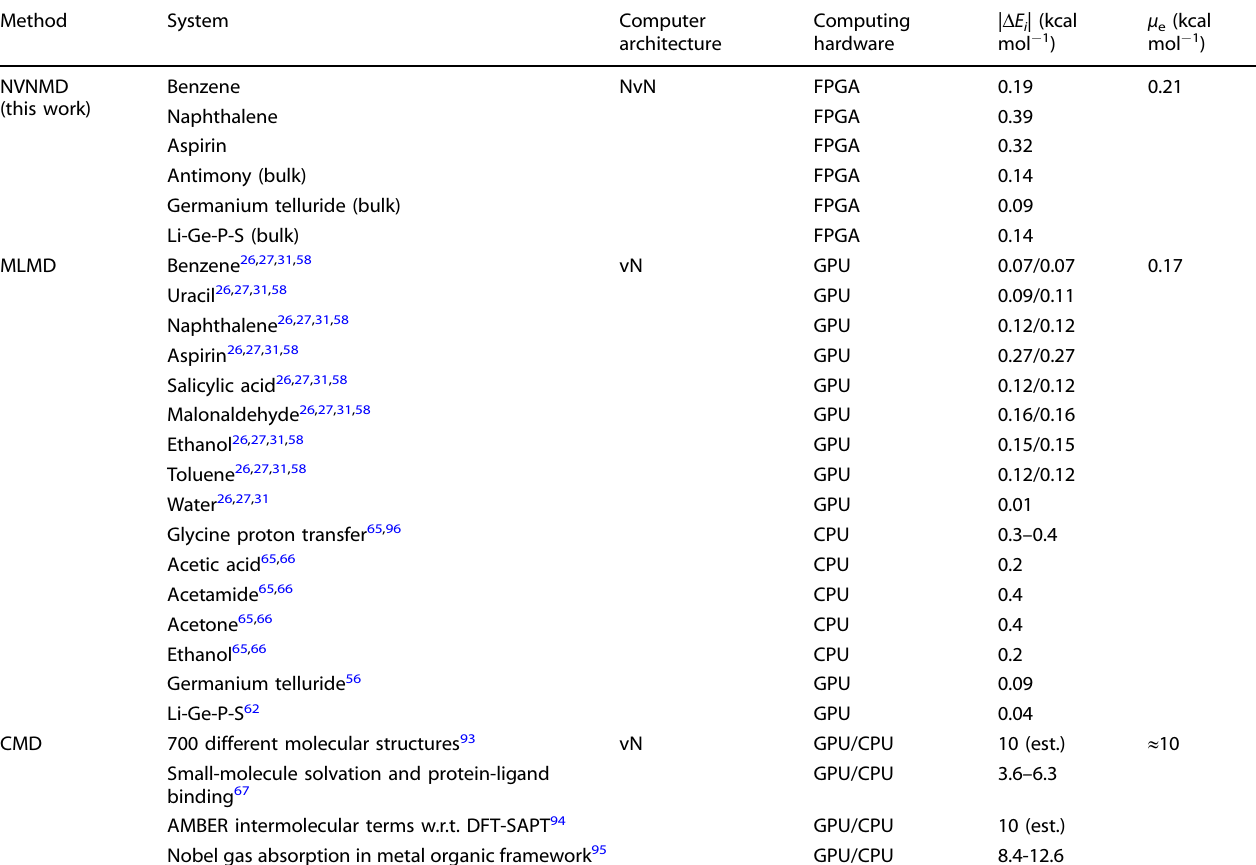
Table 1. Calculation accuracy comparison between the proposed NVNMD and the established MLMD/CMD.